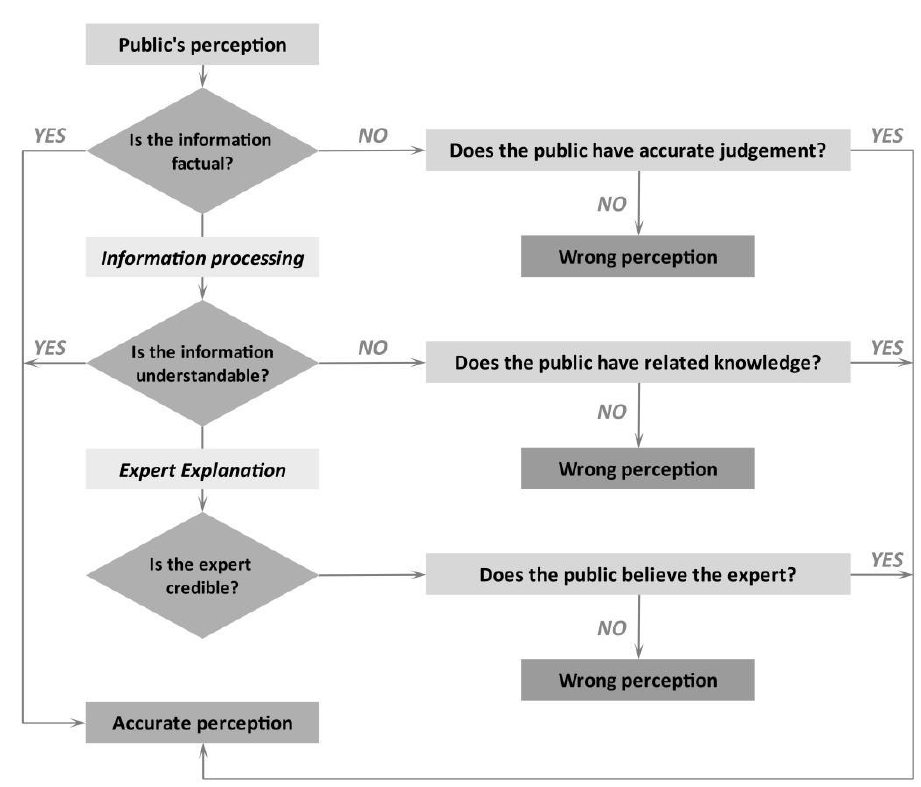
Figure 2. Tree diagram of public ’ s perception on health information.